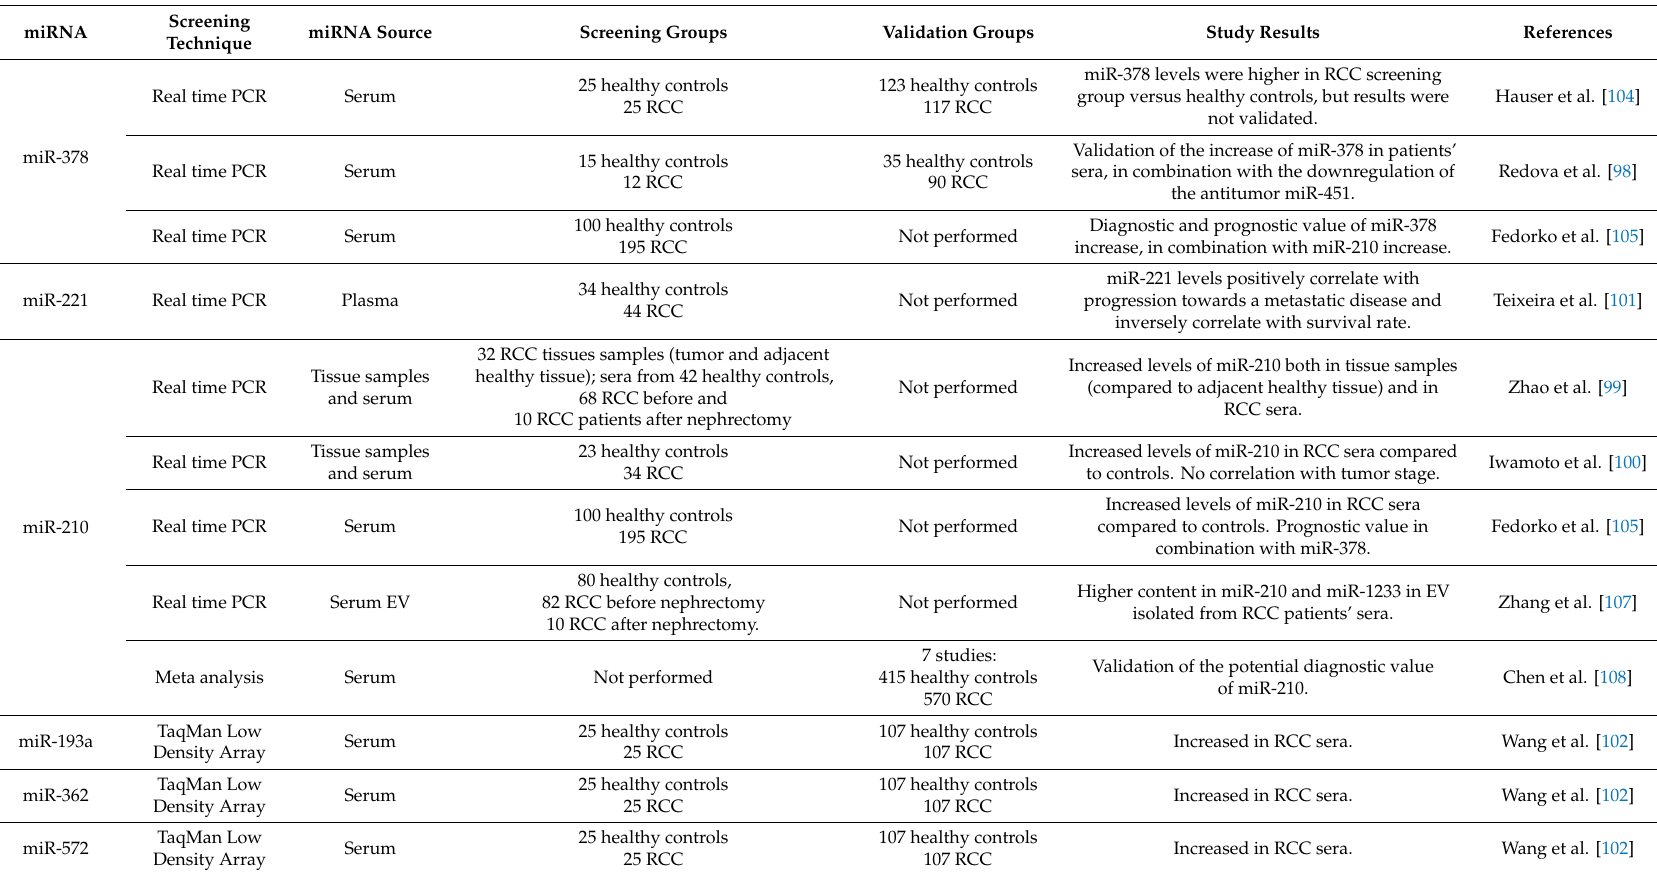
Table 2. Circulating miRNAs in RCC patients. The table lists some of the circulating miRNAs isolated in serum of RCC patients and specifies the screening technique, screening groups and